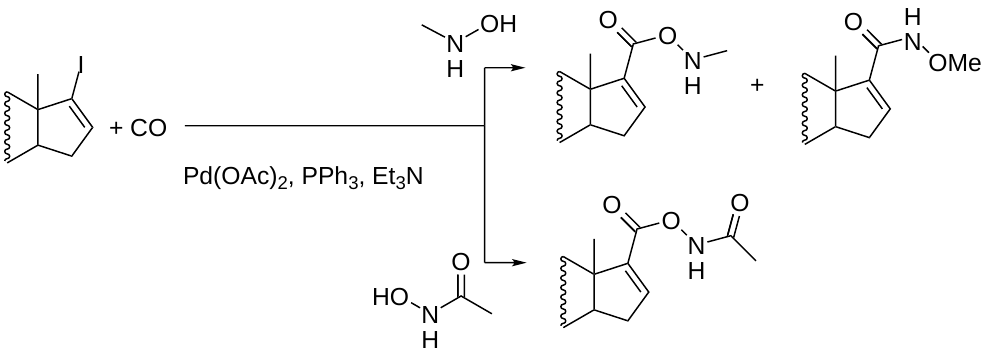
Figure 14. Formation of hydroxamic acid derivatives in Pd-catalyzed carbonylation reactions. The Pd-catalyzed hydrazinocarbonylation of some steroid derivatives possessing iodo- alkenyl moiety were carried out in the presence of a base and acetic or benzoic hydrazide as the nucleophilic reagent. The corresponding N-acetamido-carbamoyl or N-benzamido- carbamoyl derivatives were obtained in high yields. Some of these products served as starting materials for the synthesis of new steroidal 1,3,4-oxadiazole compounds [69].